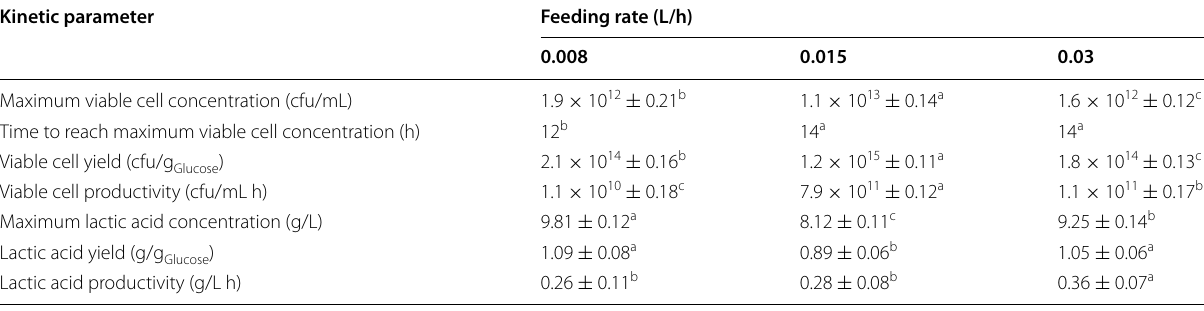
The results presented are the average of triplicate experiments and are expressed as mean a,b,c Mean values in the same row with different superscripts are significantly different from each other (P < 0.05)